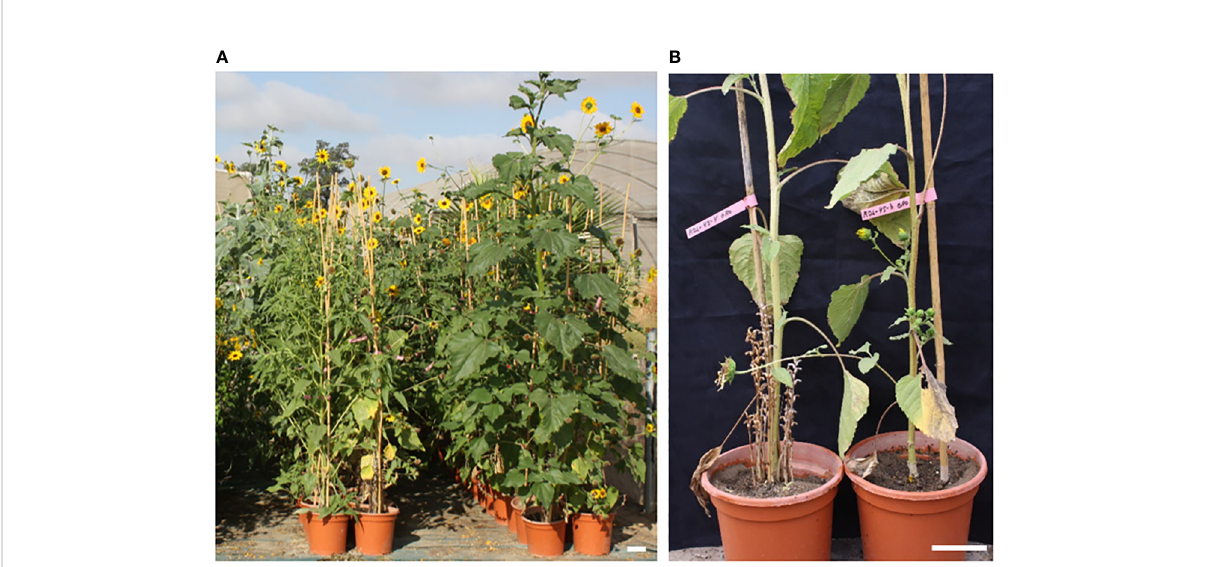
FIGURE 2 Phenotyping wild Helianthus species in 6 L pots for their resistance to O. cumana. (A) Global view of a phenotyping assay in 6 L pots of wild Helianthus species. Screening was performed by counting the number of emergences/pot at the fl owering stage of wild Helianthus. (B) Segregating resistance of the H. annuus accession #774: on the left, susceptible plant with more than 10 emergences and on the right, resistant plant with no emergence. Bar = 10